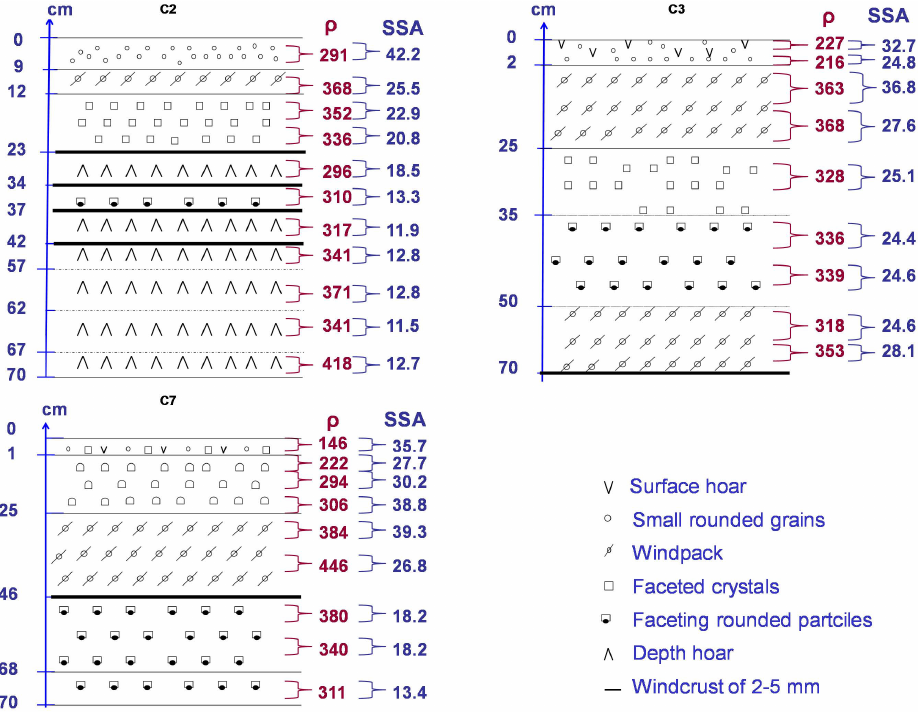
Fig. 3. Stratigraphy, density ( ρ) in kgm − 3 and SSA in m 2 kg − 1 of pits C2, C3 and C7.